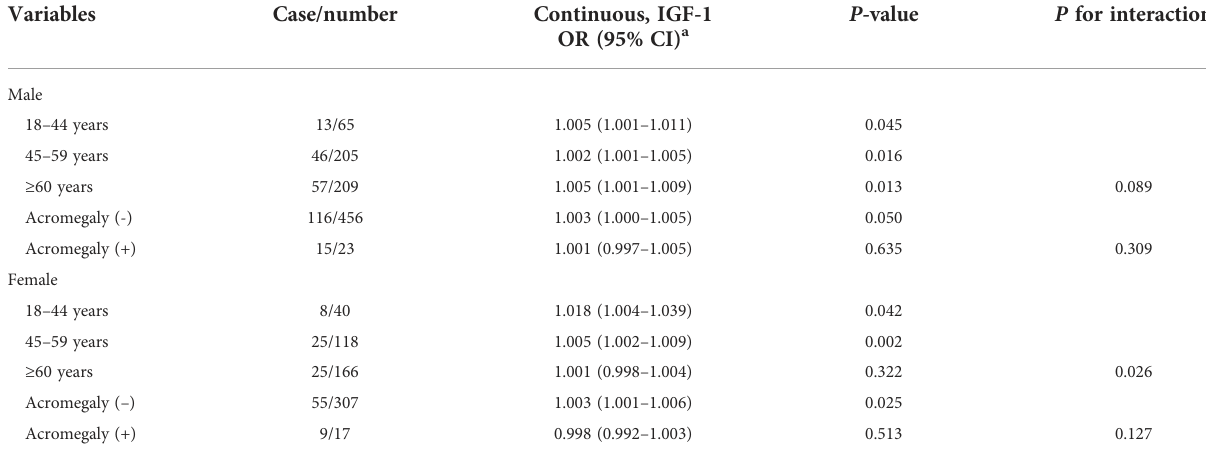
TABLE 4 Association between insulin-like growth factor-1 and interventricular septal thickening strati fi ed by sex, age, and acromegaly.